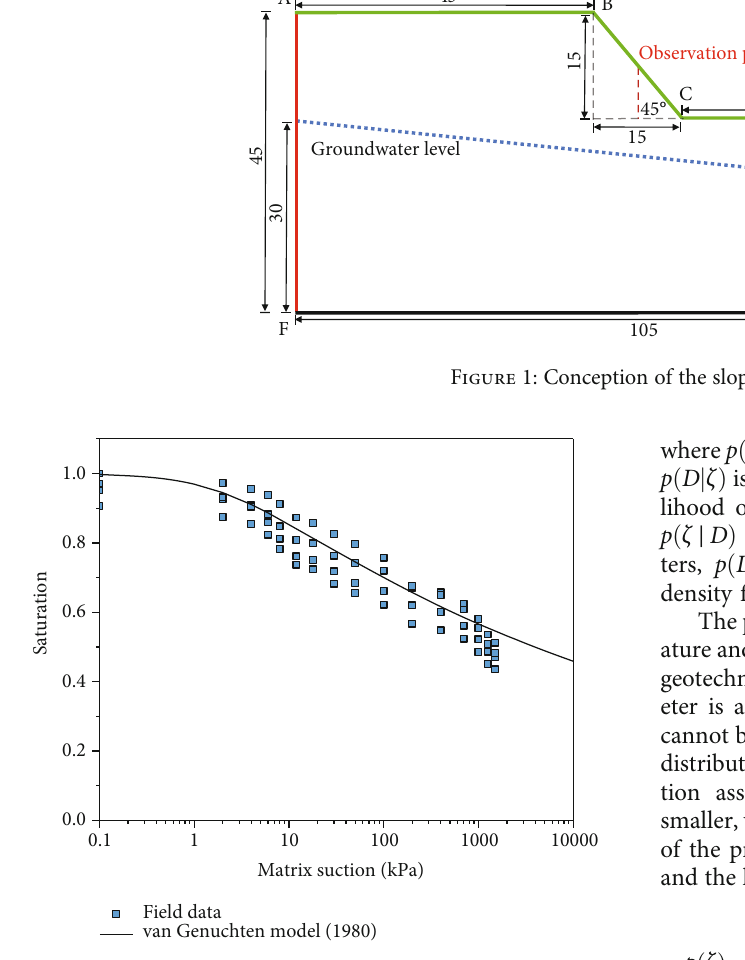
Figure 2: Fitting the optimal parameters of the SWRC with fi eld